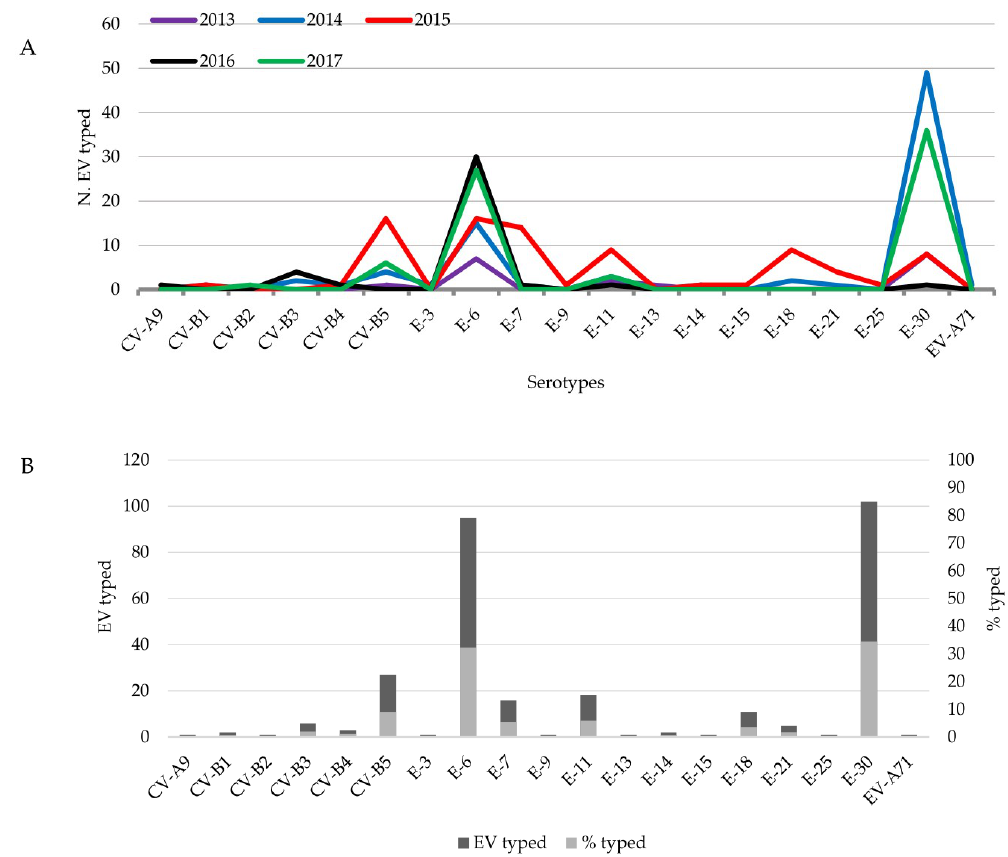
Figure 3. Enterovirus serotypes detected between 2013 and 2017 from aseptic meningitis patients. ( A ). Enterovirus serotypes identified per year (2013–2017). ( B ). Total number of typed enterovirus and relative number per